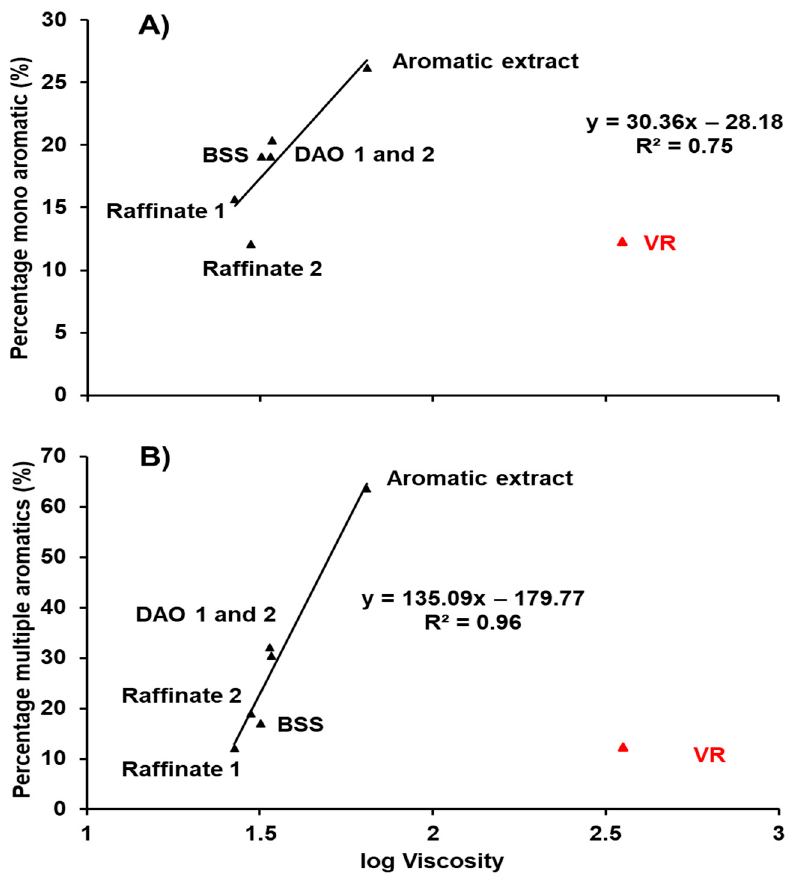
Figure 3. Correlation between the percentage of monoaromatic ( A ) and multiple aromatic ( B ) compounds and the log of viscosity for all the samples except vacuum residue (VR) (in red) and wax.